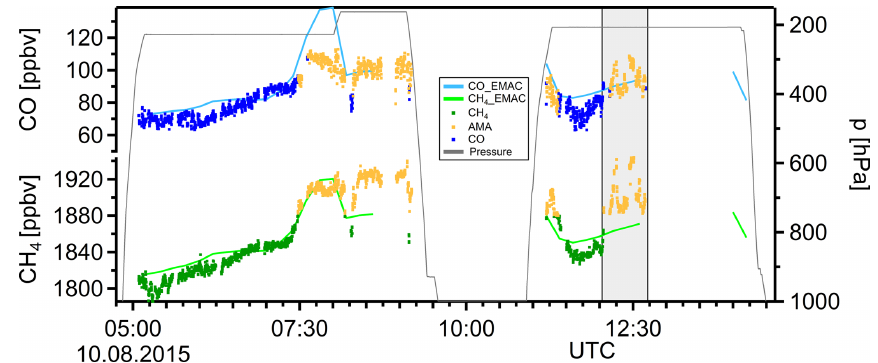
Figure 23. Flight 17/18 (10 August 2015) in situ CH 4 and CO data and EMAC results along the flight track, as well as the flight altitude. The AMA is colour-coded by CH 4